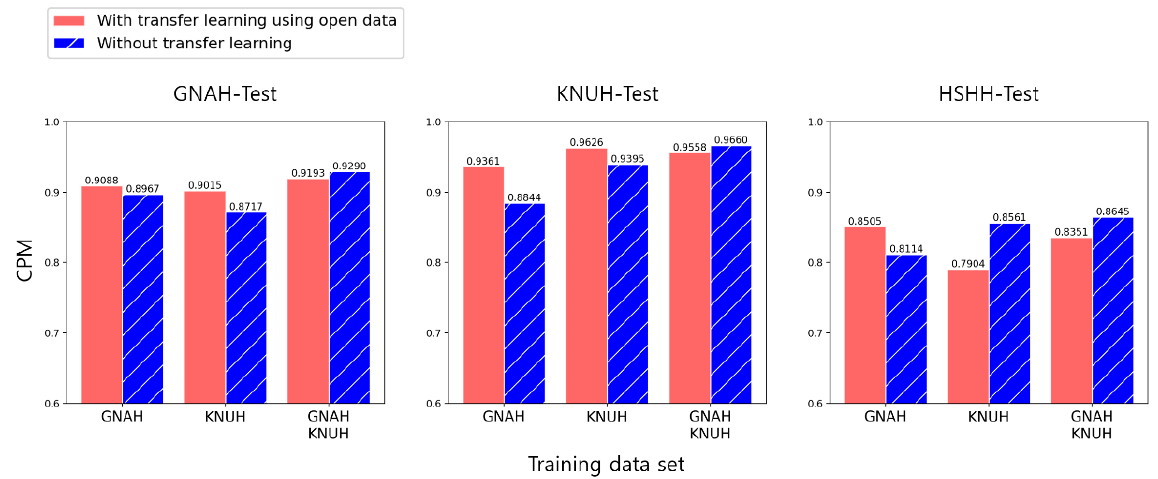
Figure 7. Comparison of the performance of the models with transfer learning from open data and without transfer learning.